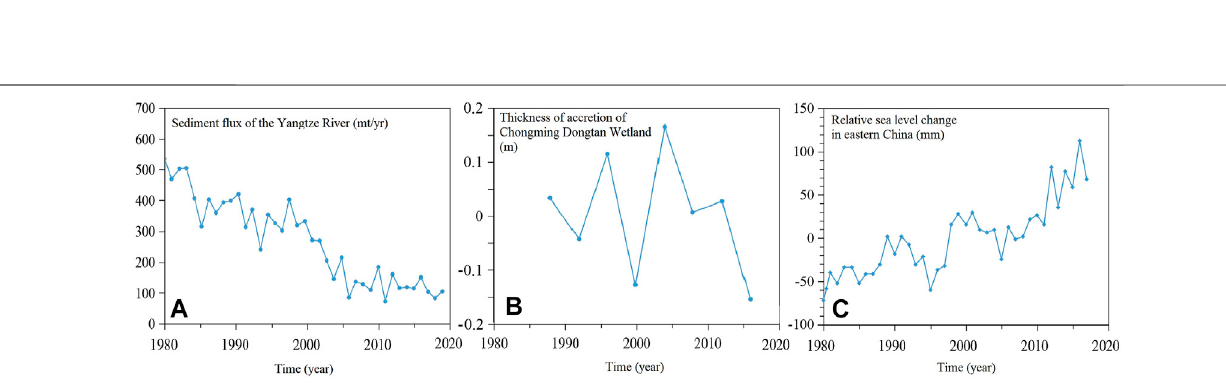
FIGURE 9 | The time-series of sea level, sediment fl ux and tidal fl at accretion/erosion during 1980 – 2020: (A) sediment discharge from the Yangtze river in 1980 – 2002 (after Wei, 2015), and data in 2003 – 2019 were collected from Bulletin of China River Sediment (Ministry of Water Resources, 2003 – 2019, see Appendix Table A2); (B) sedimentation rates at the Dongtan wetlands (after He, 2020) and (C) local sea level curve (from Wang, 2018).